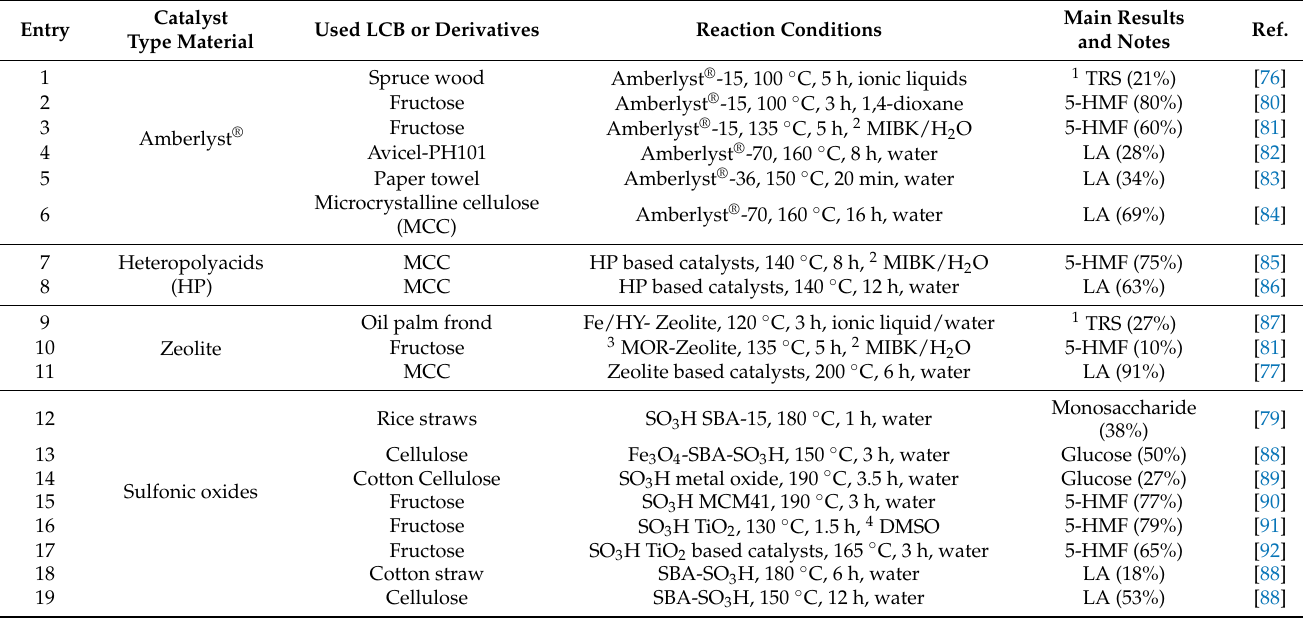
Table 3. Comparative studies on hydrolysis cellulose based materials of selected solid acid catalysts activity under different reaction